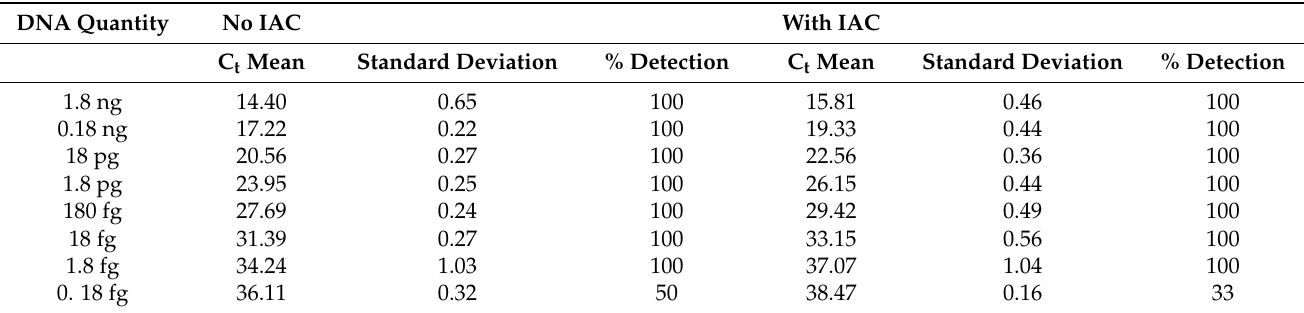
Table 2. ITS real-time quantitative PCR (qPCR) assay sensitivity results using DNA from S. parasitica mycelium with or without internal amplification control (IAC) (n = 6).